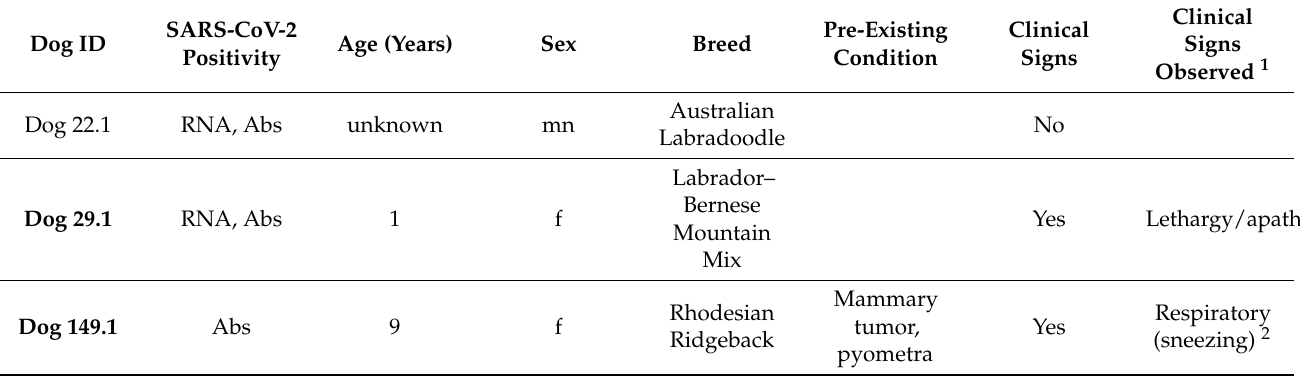
Table 3. Characteristic of SARS-CoV-2 Delta-lineage-positive dogs and clinical signs